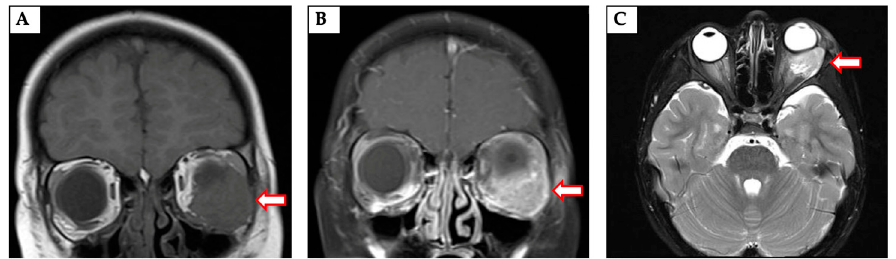
Figure 2. Magnetic resonance imaging (MRI) of an orbital primary tumor (arrows) in coronal T1 pre-contrast (Panel A ) and post-contrast (Panel B ) and axial T2 (Panel C ) sequences. Panel ( B ) demonstrates the utility of contrast administration and fat suppression in delineating tumor for diagnosis and treatment planning.